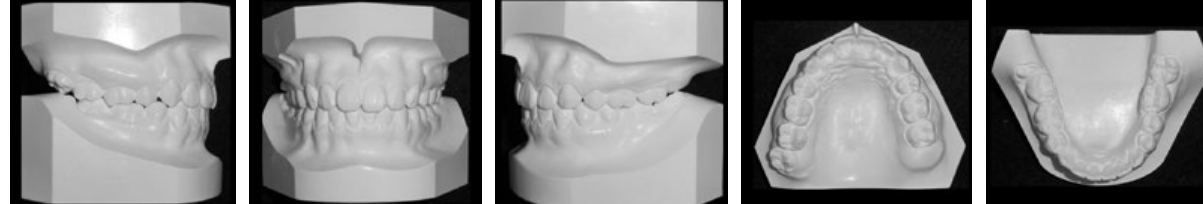
Figure 10. Post-treatment dental casts. A